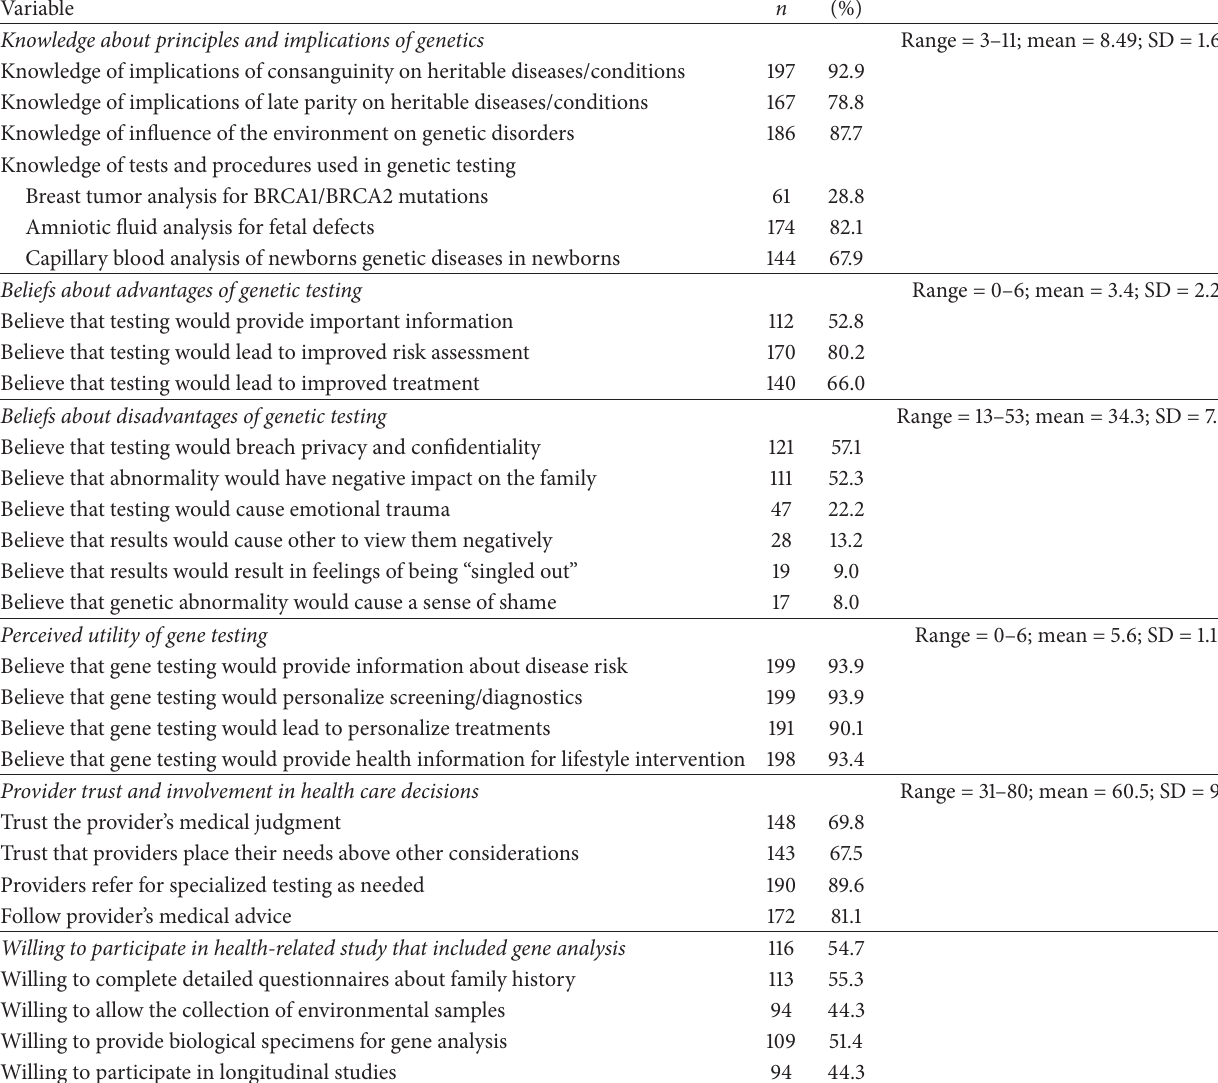
Table 2: Knowledge, perceptions, beliefs, and willingness to engage in health-related genetic research ( 𝑁 = 212